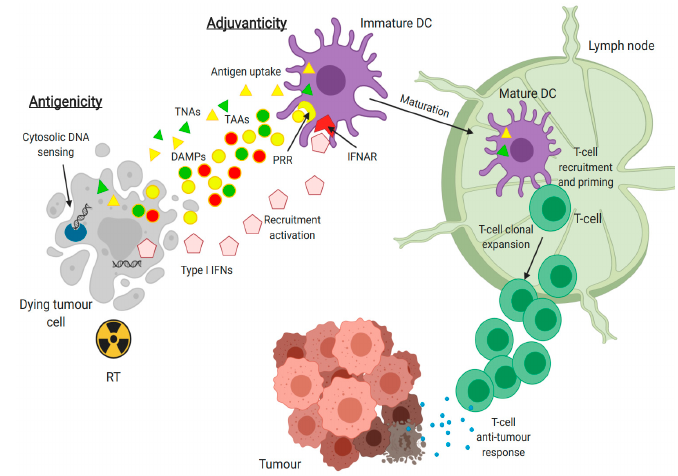
Figure 2. Simplified presentation of radiation-induced immunogenic cell death. Damage induced by RT mediates the release of tumor neoantigens (TNAs) or tumor-associated antigens (TAAs) and